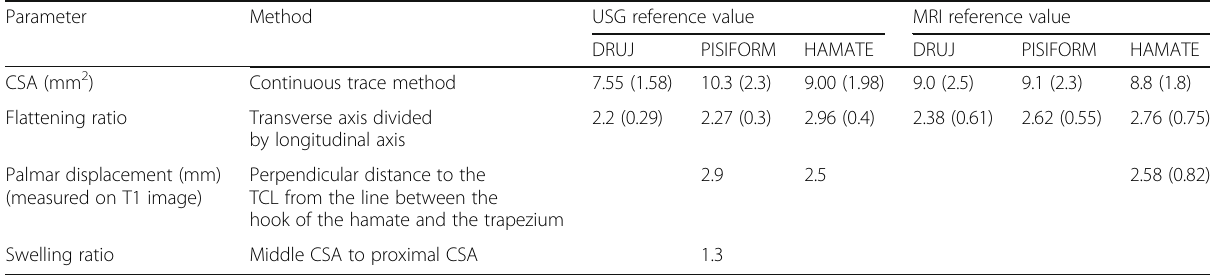
Table 5 Parameter for evaluation of carpal tunnel syndrome [18, 19] Parameter Method